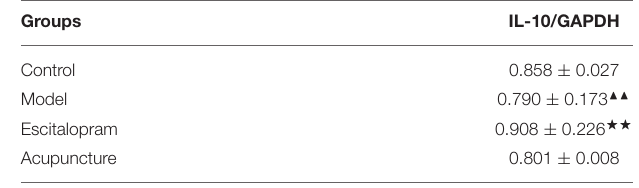
TABLE 4 | Effects of acupuncture on the expression of IL-10 protein in the hippocampus of CRS rats.